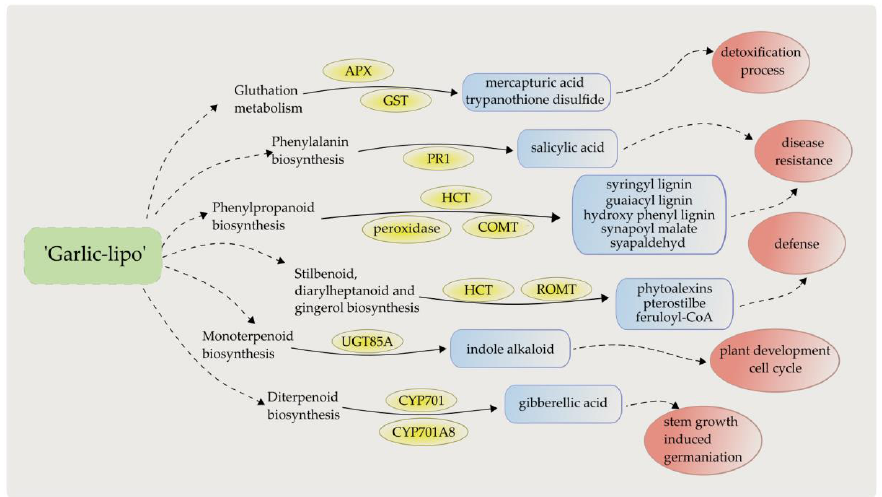
Figure 8. Summary of up-regulated DEGs (yellow) found in the KEGG pathways (not colored), with the patway-related secondary metabolites (blue), and their physiological roles (red) in defense mechanism and plant development as a response to ‘Garlic - lipo’ treatment.